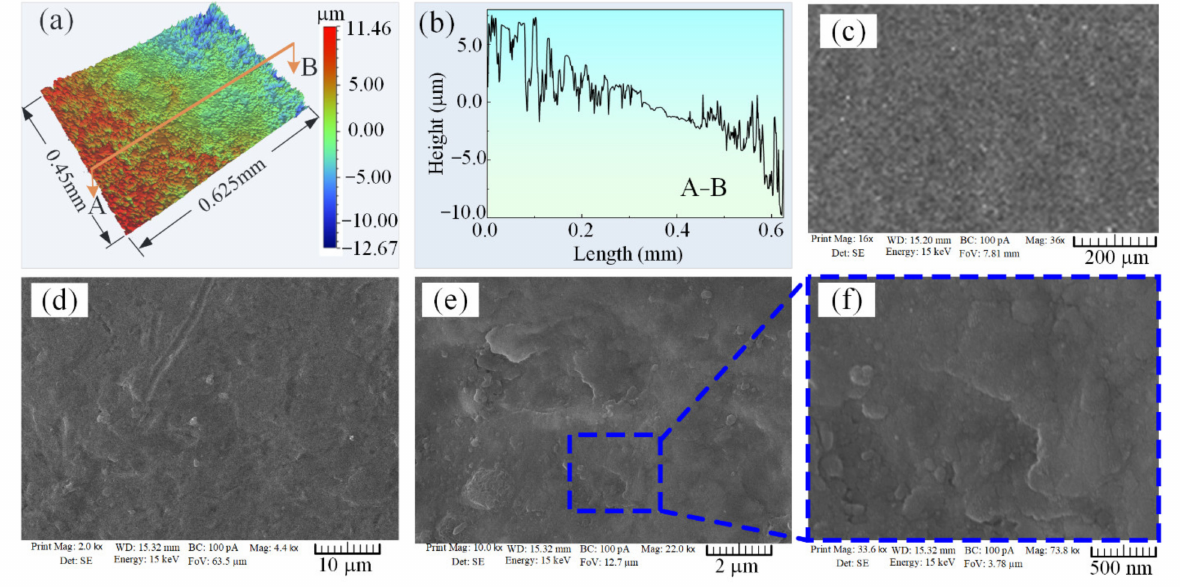
Figure 5. The optical micrographs ( a ), height profile images ( b ), SEM micrographs and their enlarged appearances ( c – f ) of USP specimen. A-B means the cross section of micrographs through line